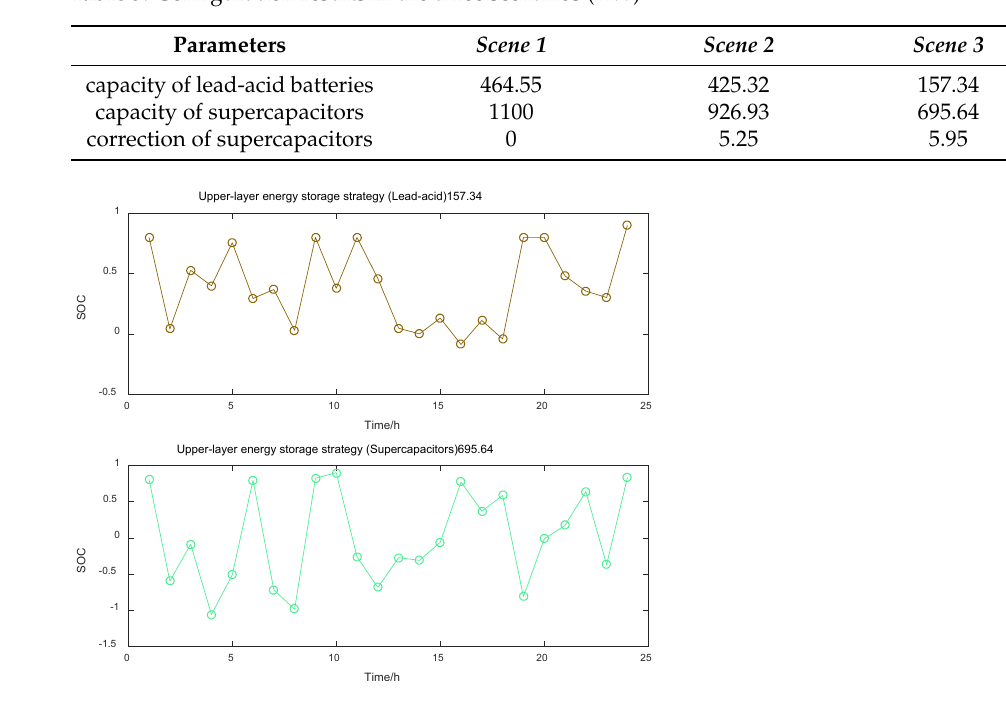
Figure 7. Effect of different access points on active power network loss.